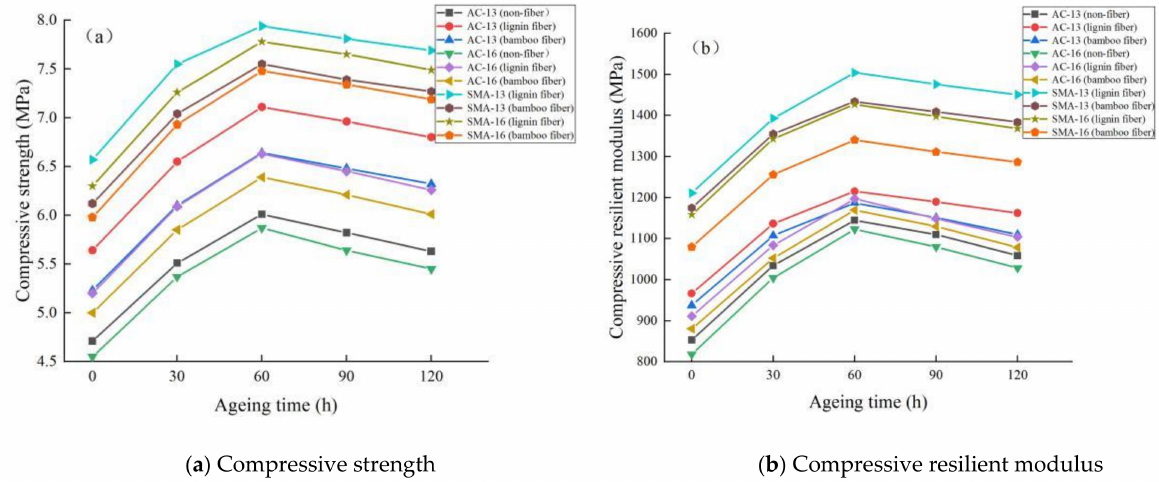
Figure 3. Uniaxial compression test results of fiber asphalt mixture under different ageing